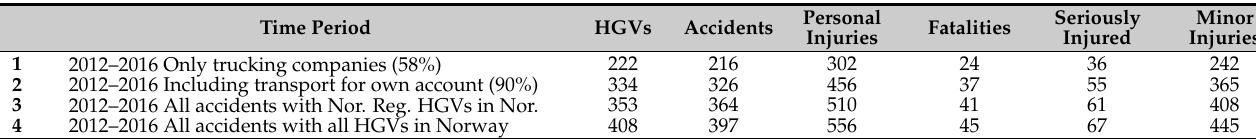
Table 5. Average for Norwegian registered, employee-driven HGVs in accidents involving personal injuries per year in the period 2012–2016, and the average number of accidents and personal injuries in the accidents.